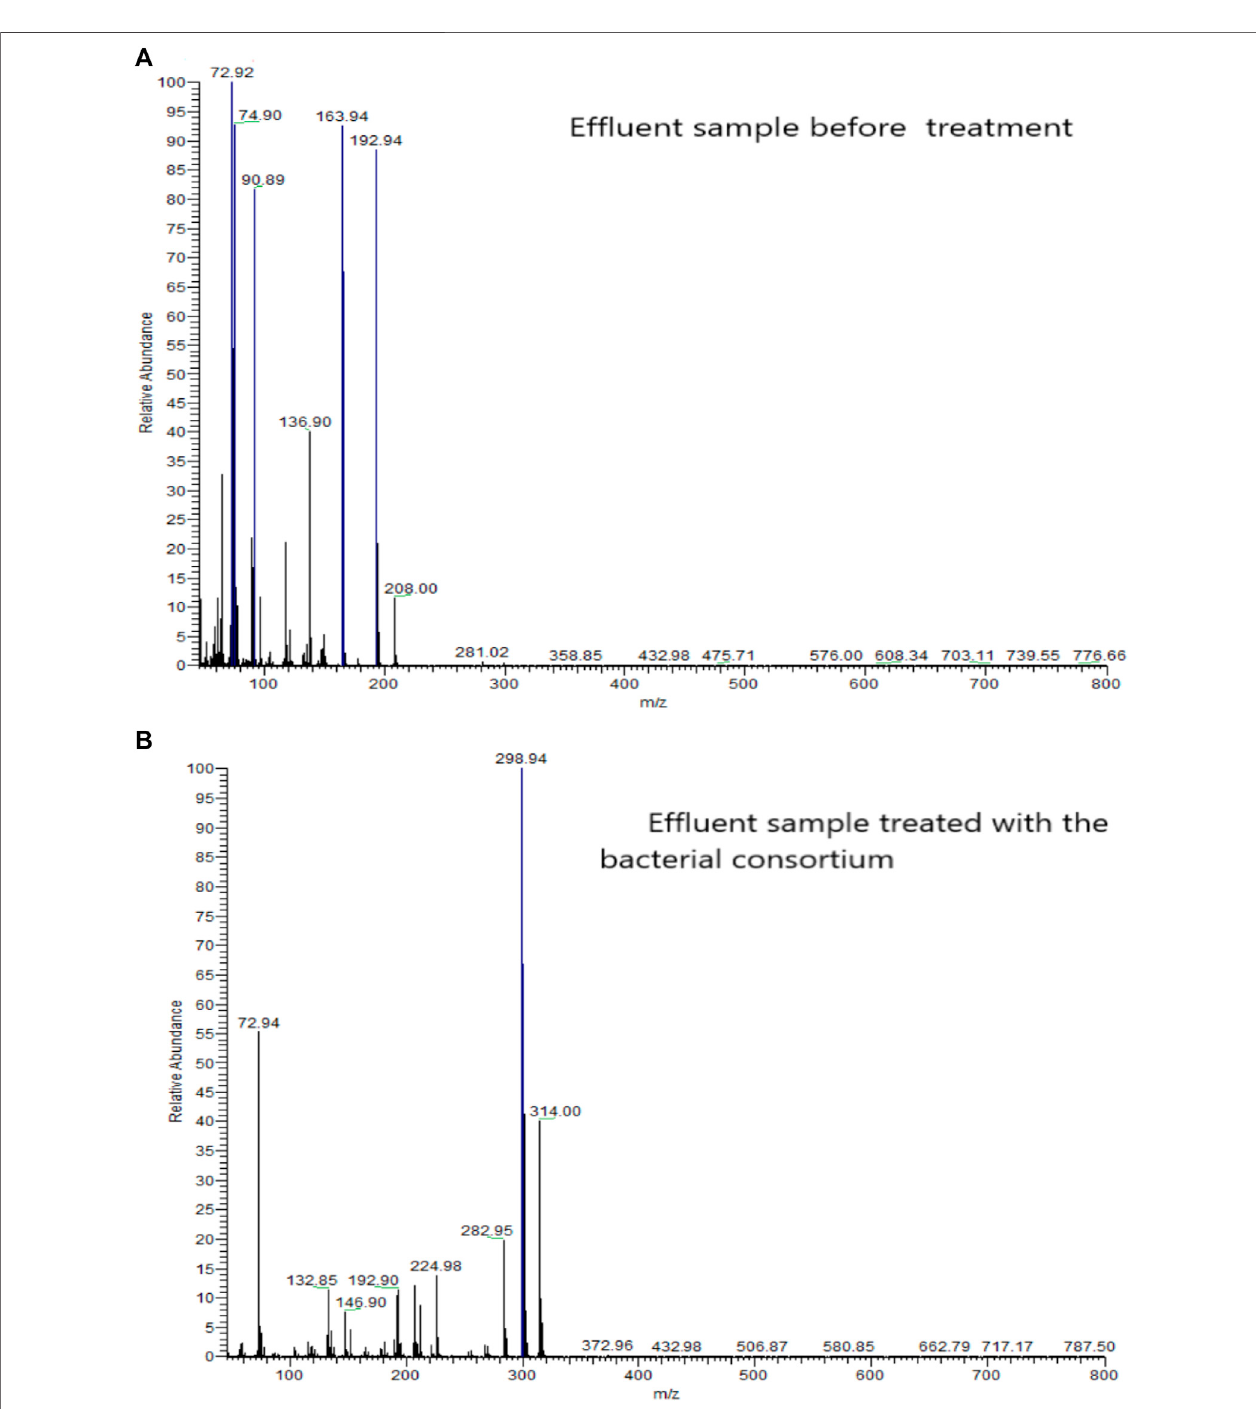
FIGURE 5 | (A) GC-MS analysis of ef fl uent before treatment and (B) GC-MS analysis of ef fl uent after bacterial treatment.